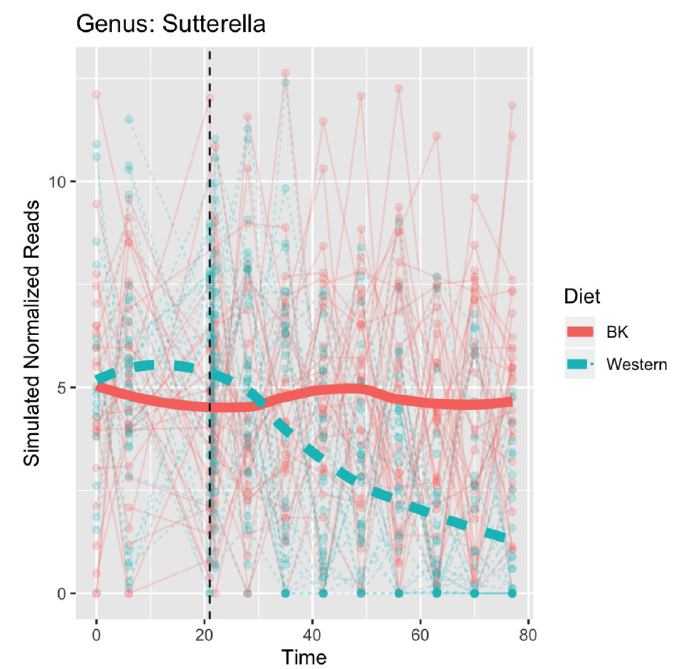
Figure 6. Estimated functional form of the longitudinal differential abundance for the Western diet group from Turnbaugh et al. 10 study for the Genus Sutterella with the corresponding functional form chosen for the simulation shown in blue. The black line represents the point estimate with the dashed red lines corresponding to 95% confidence intervals using metaSplines to fit smoothed spline